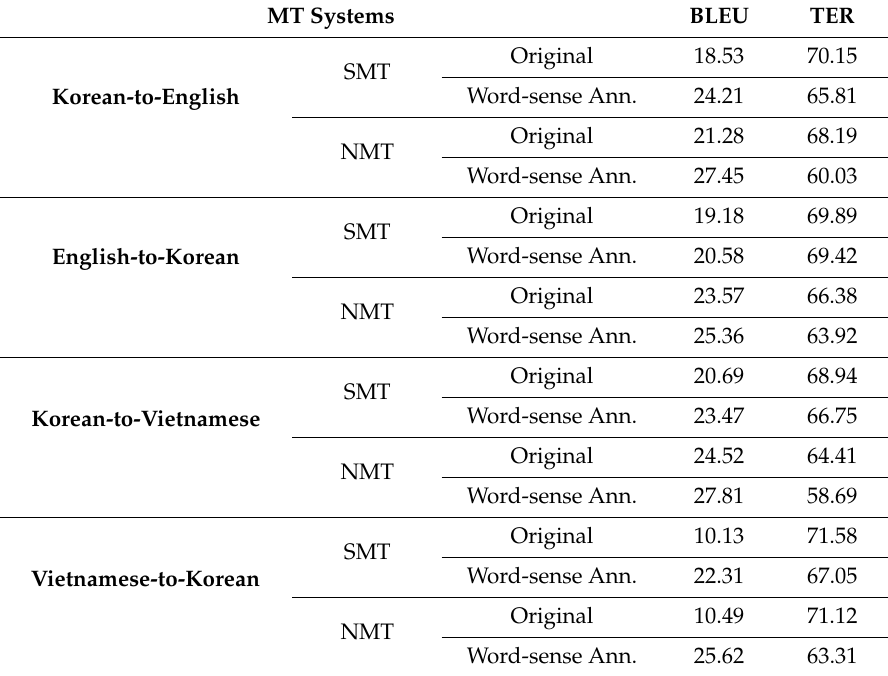
Table 12. Translation results in BLEU and TER scores. MT = machine translation, SMT = statistical MT, and NMT = neural